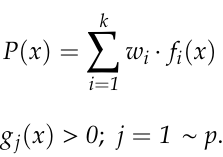
Figure 7. Power transfer efficiency (PTE) according to each coupling coefficient: ( a ) k 34 = 0.178; ( b ) k 34 = 0.04.